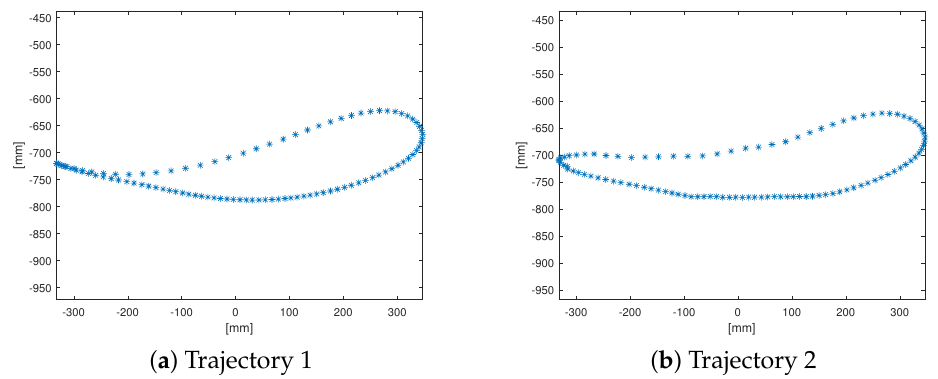
Figure 6. cam–linkage precision points for the synthesis